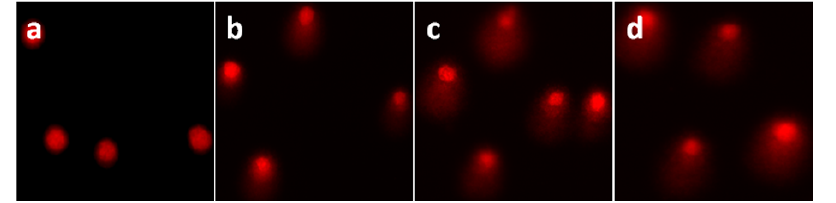
Figure 5. Comet assay of SGC-7901 (control, a ) after exposure to 1 (4.0 µM) ( b ), 2 (15.0 µM) ( c ), or 3 (15.0 µM) ( d ) for 24 h.